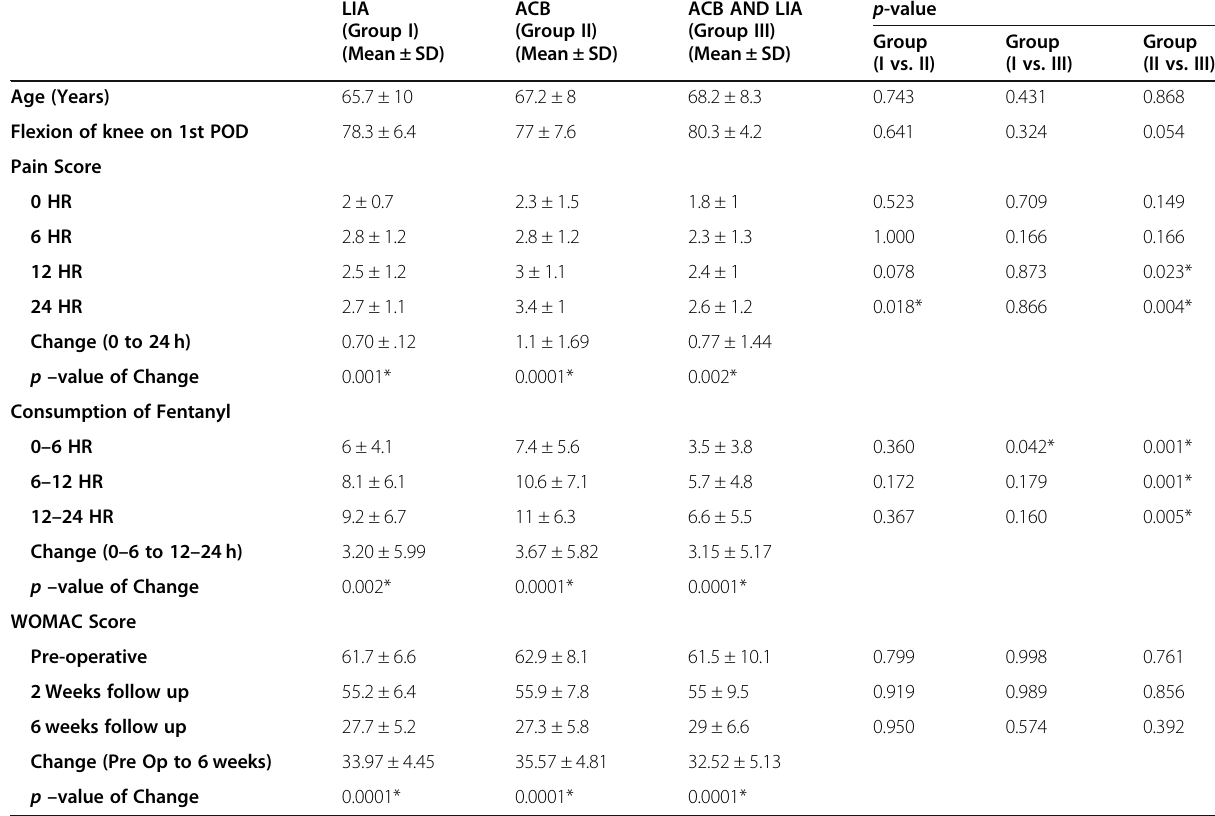
Table 1 Comparison of study parameters between groups